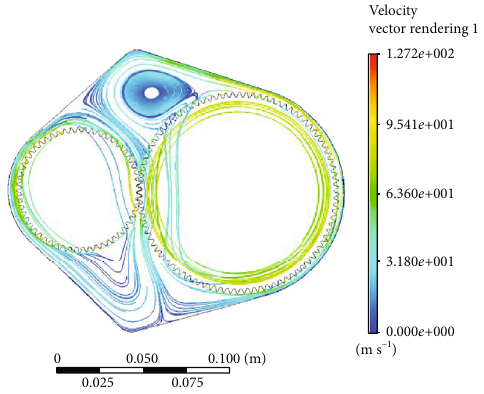
Figure 5: Velocity streamlines. Figure 6: Velocity volume rendering of the internal fl ow fi